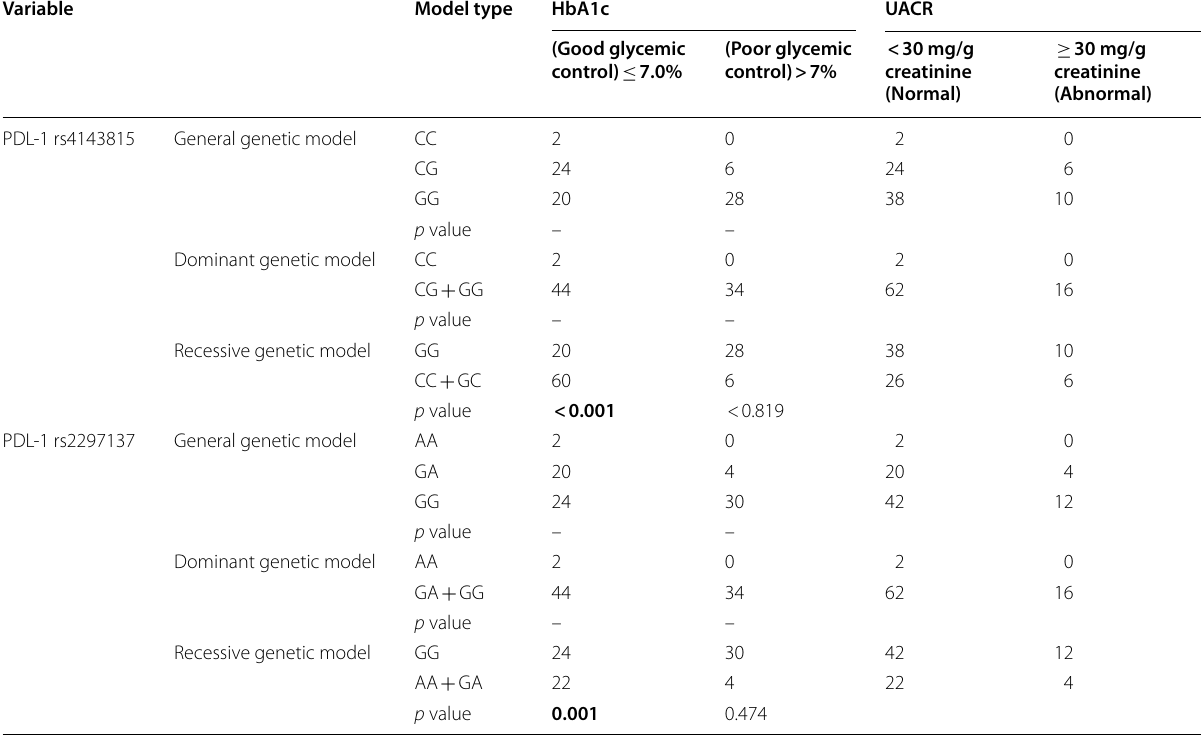
UACR, urinary albumin/creatinine ratio; rs, recognition site; PDL-1, programmed death-ligand 1 Bold values indicate the p-value < 0.01 is highly significant